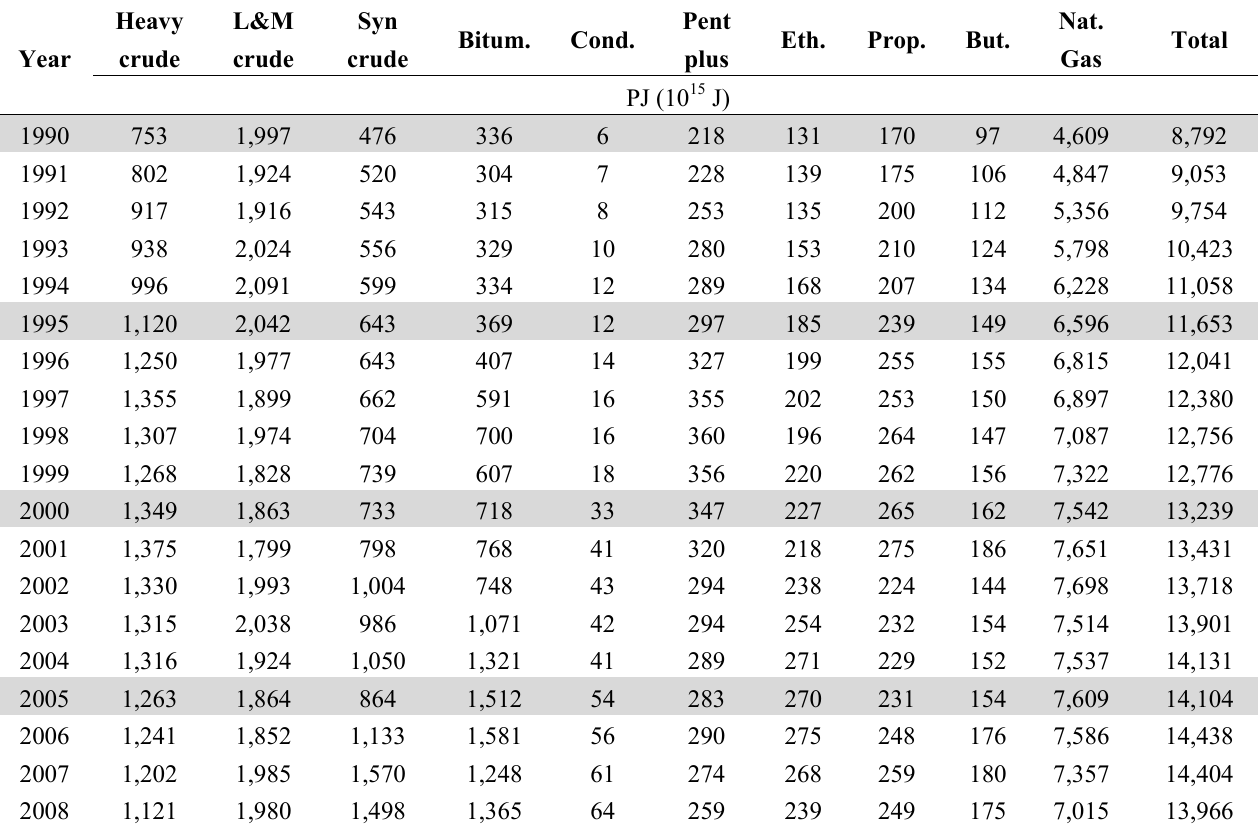
Table 3. Canadian Oil and Gas Production (Return), in energy units (derived from Tables 1 and